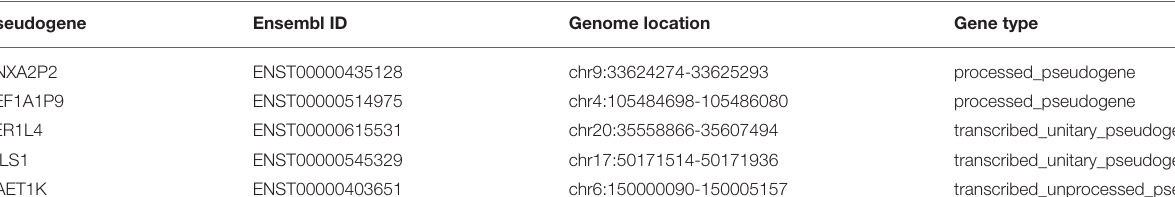
TABLE 2 | Information on the five pseudogenes identified by dreamBase.